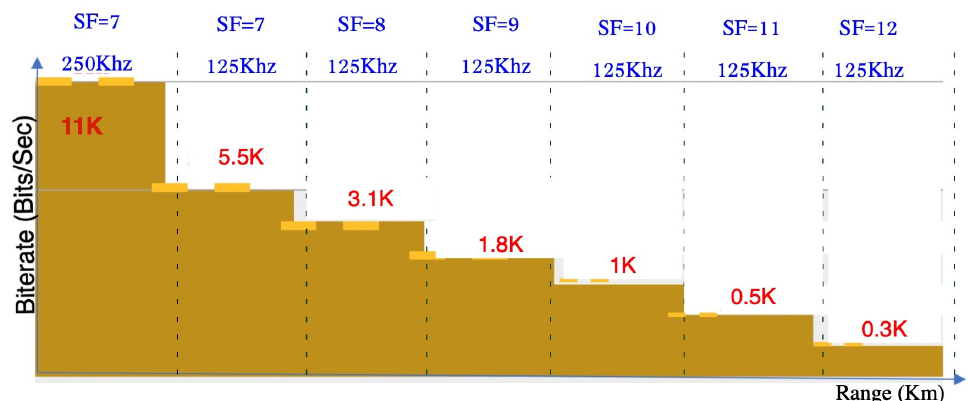
Figure 2. LoRaWAN bit rate variation according to SF and BW parameters